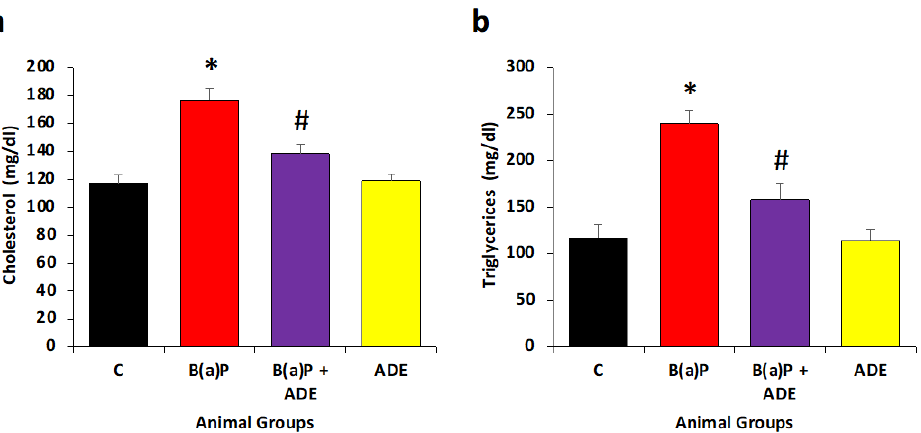
Figure 4. The level of ( a ) total cholesterol and ( b ) triglyceride level was significantly increased in B(a)P-treated group. This level of these parameters significantly decreased in the ADE treatment group. The numbers signify the mean ± SEM with 8 animals per group. The statistical differences are represented with asterisk (*) representing significance at ( p < 0.05) as compared to the normal control group and hash (#) represents ( p < 0.05) as compared with B(a)P-treated group only.